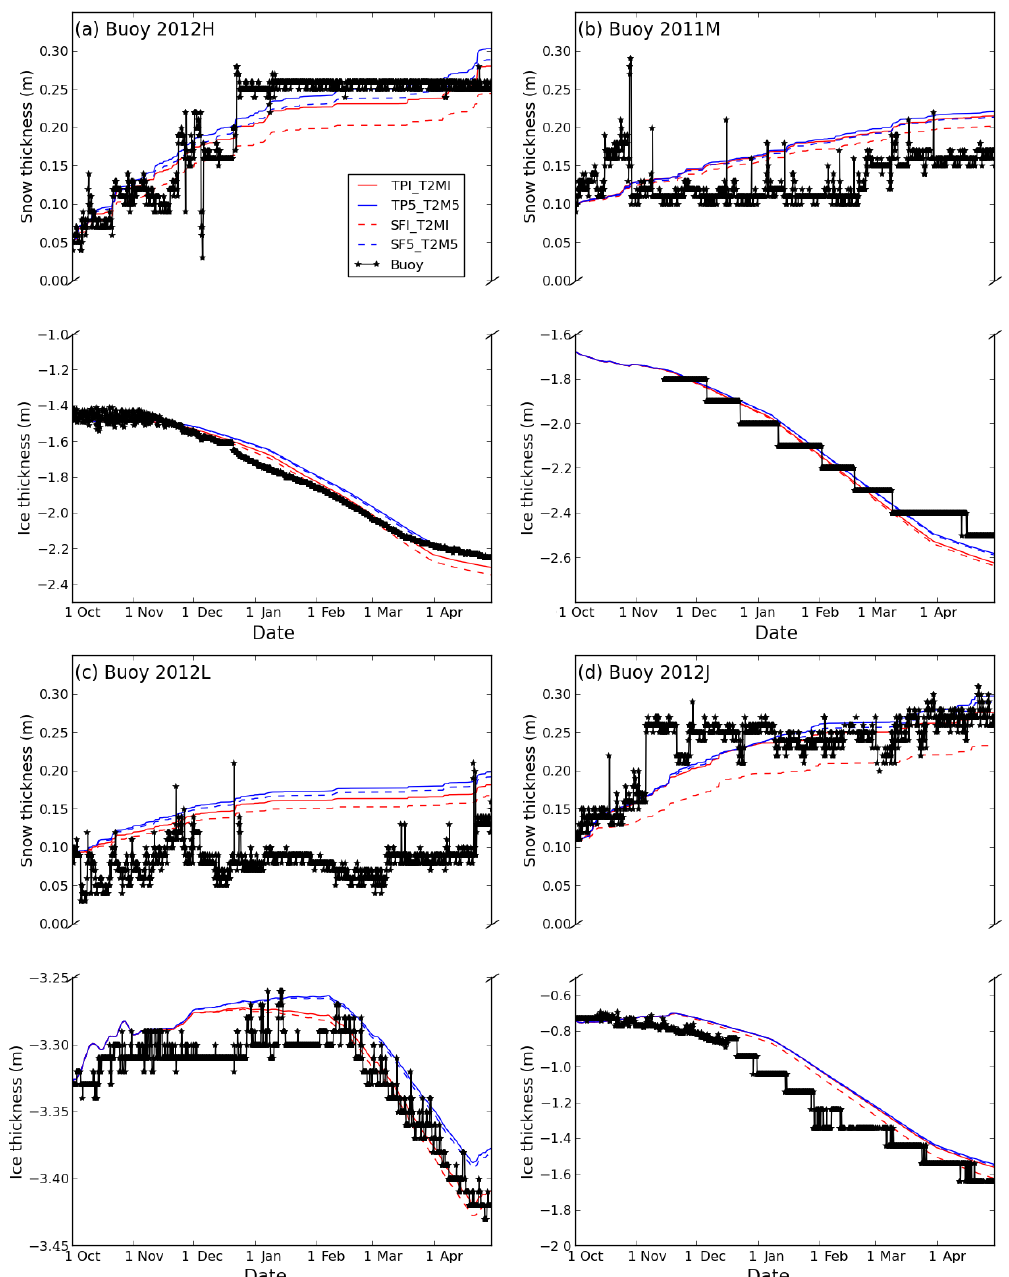
Figure 9. Evolution of snow and sea ice thickness during the freezing season based on simulations with HIGHTSI for (a) buoy 2012H, (b) buoy 2011M, (c) buoy 2012L and (d) buoy 2012J for runs TPI_T2MI, TP5_T2M5, SFI_T2MI and